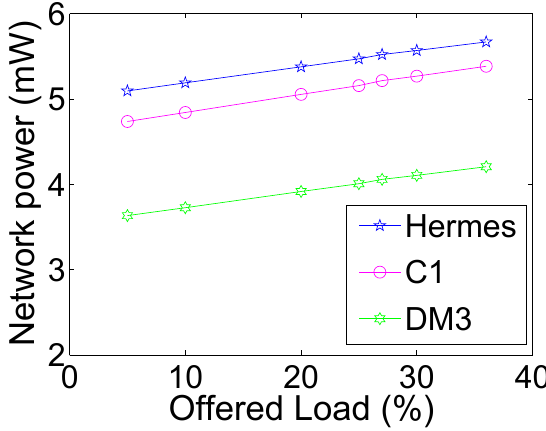
Figure 24. Network-level power consumption